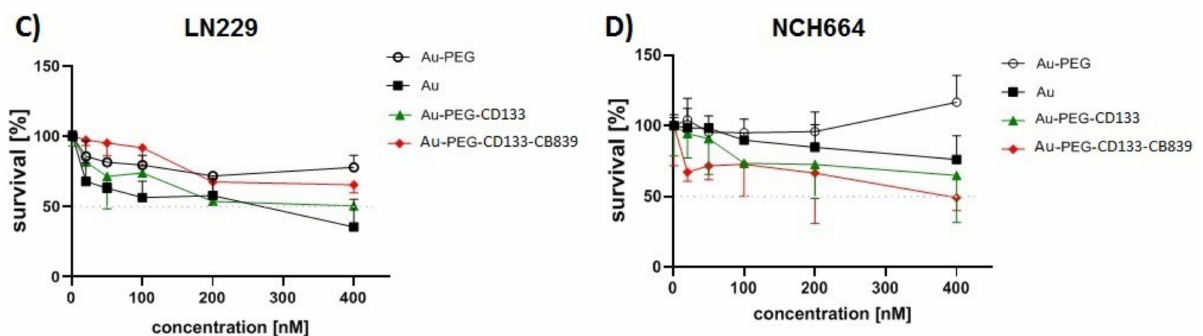
Figure 6. Cytotoxic effects of Nano-CB-839 on GSCs and GBM cells. These results exhibited the inhibitory efficacy of Au-PEG-CD133-CB-839 as well as other similar compounds in different concen- trations after 24 h. Regarding the obtained data, the concentration of 20 nM was selected as a lower concentration close to IC50 to treat the GCSs and GBM cells for the main analysis of cell proliferation.